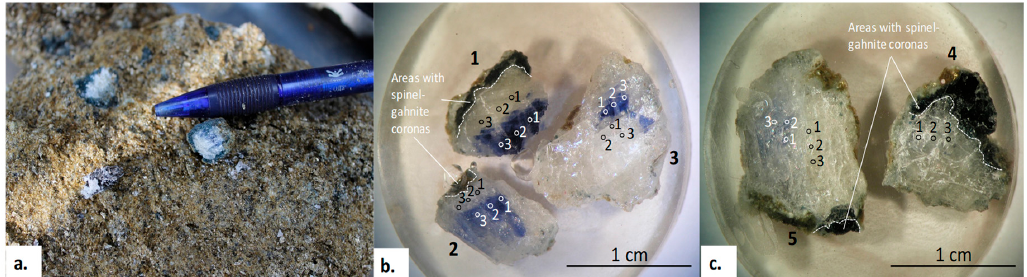
Figure 2. Photographs of corundum–spinel–chlorite–muscovite rock: ( a ) Corundum–spinel concentric aggregates embedded in a muscovite-chlorite matrix; ( b ) Corundum-blue sapphire–spinel samples No-s 1–3 with spot positions for Laser Ablation-Inductively Coupled Plasma-Mass Spectrometry (LA-ICP-MS) analyses from Table 1 mounted in the epoxy resin; ( c ) Corundum-blue sapphire-spinel samples No-s 4 and 5 with spots positions for LA-ICP-MS analyses from Table 1 mounted in the epoxy resin. Photographs by Elena S